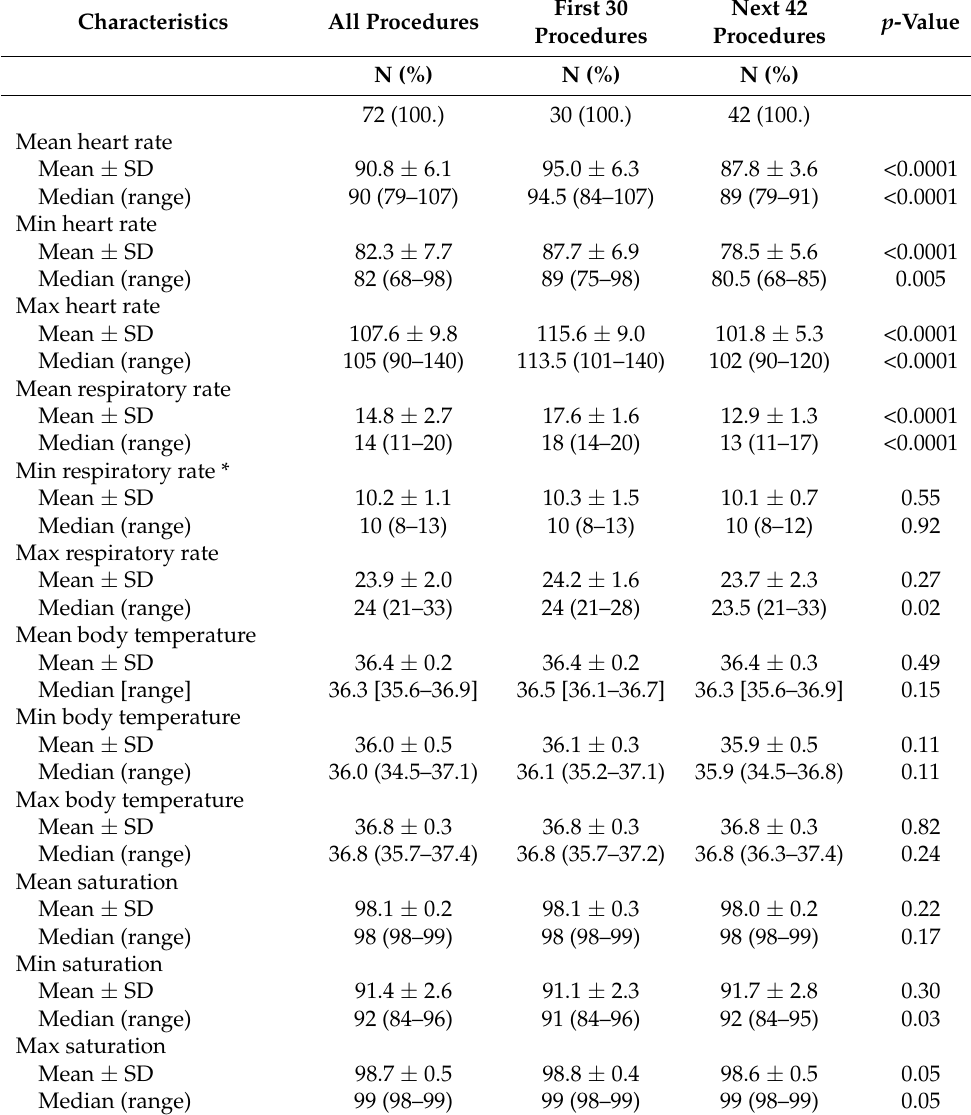
Table 2. Surgeon’s cardiovascular and respiratory